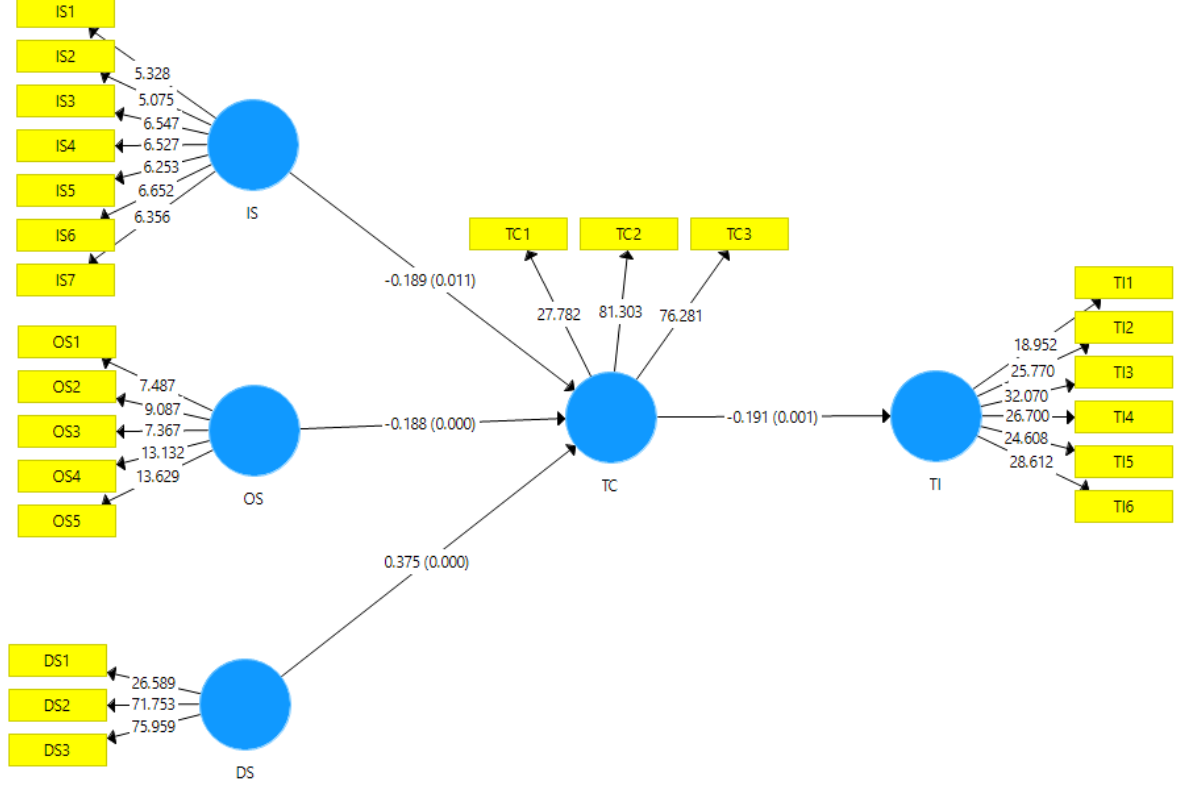
Figure 3. Results of the structural